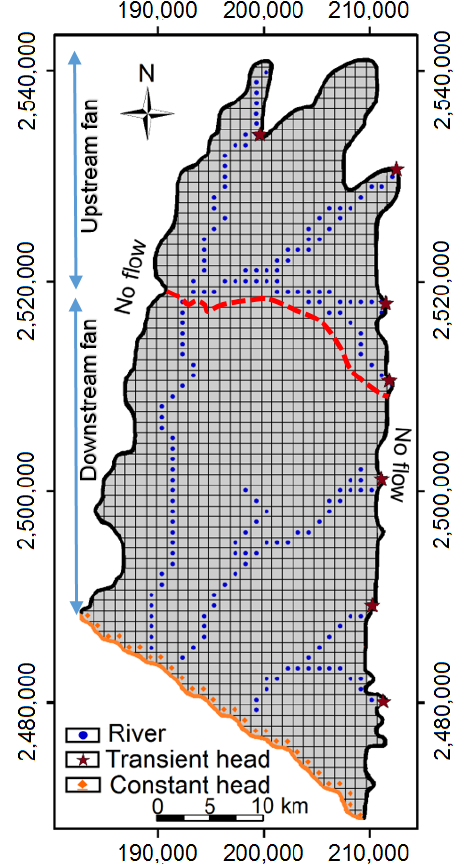
Figure 4. The conceptual model and boundary conditions for the specified simulation domains. The dashed line defines the boundary for upstream and downstream fan areas.